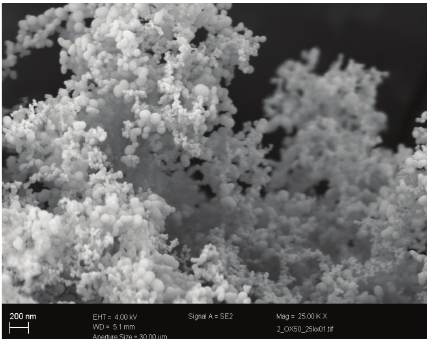
Figure 3: SEM picture of AEROSIL OX 50.